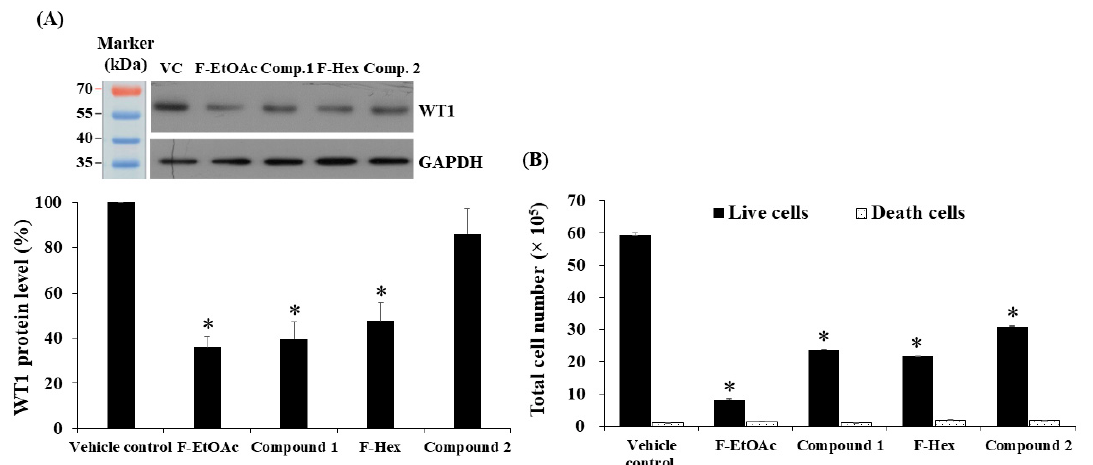
Figure 8. Effect of F-EtOAc, compound 1 , F-Hex, and compound 2 on KG-1a cells. ( A ) The level of WT1 protein following treatment F-EtOAc (4.58 µg/mL), compound 1 (comp. 1 ; 2.30 µg/mL), F-Hex (26.29 µg/mL), or compound 2 (comp. 2 ; 29.90 µg/mL) for 48 h. Protein levels were evaluated using Western blotting and analysed using scan densitometer. The levels of WT1 were normalised using glyceraldehyde phosphate dehydrogenase (GAPDH) protein levels. ( B ) Total cell number after treatment with F-EtOAc, compound 1 , F-Hex, and compound 2 for 48 h was determined via the trypan blue exclusion method. Each bar represented mean ± SD of three independent experiments performed in triplicate. Asterisks (*) denote significant differences between C. comosa extracts and vehicle control (* p < 0.05).